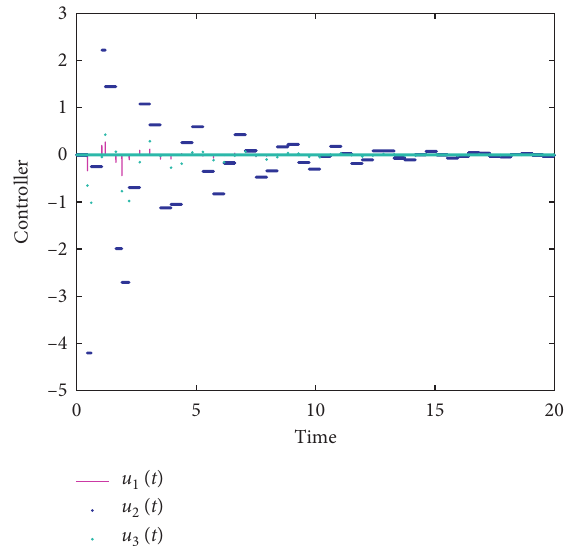
Figure 3: The dynamics of control inputs.